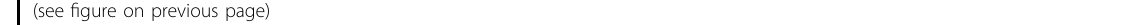
Fig. 5 Glutamine oncometabolites and energy production from glutamine. a Several mutations in enzymes in the glutaminolysis pathway are responsible for the production of oncometabolites. Mutation of IDH1 and IDH2 produces R-2-HG from α -KG, which, when accumulated, leads to the inhibition of dioxygenases, in turn leading to the activation of TET and JHDM enzymes inside the nucleus. Mutation of SDH arrests the TCA cycle, resulting in an increase in the succinate concentration. A high concentration of succinate has an effect similar to the oncometabolite effect of R-2-HG. Additionally, impaired function of FH prevents further metabolism of fumarate, leading to its accumulation. FH impairment inhibits the function of Keap1 and PHD, which stimulates the transcription of protooncogenes. Gln glutamine, Glu glutamate, α -KG α -ketoglutarate, IDH isocitrate dehydrogenase, 2OGDH 2-oxoglutarate dehydrogenase, SDH succinate dehydrogenase, FH fumarate hydratase, R-2-HG R-2-hydroxyglutarate, Keap1 Kelch-like ECH-associated protein 1, PHD prolyl hydroxylase, TETs ten-eleven translocation enzymes, JHDMs JmjC domain-containing histone demethylases, Me methylation. b . Glutamine anaplerosis is a key mitochondrial metabolic pathway for cancer cell growth and survival. In fl ux of glutamine-derived α -KG into the TCA cycle replenishes the intermediates and consequently generates NADH, FADH 2 , and GTP. The generated GTP can be readily converted to an equal amount of ATP. Additionally, glutamate and α -KG produced via glutaminolysis participate in the malate- aspartate shuttle, promoting the transport of NADH from the cytosol into mitochondria. Elevated mitochondrial NADH and FADH 2 levels collectively contribute to enhanced ATP production via OXPHOS through the ETC. Gln glutamine, Glu glutamate, Asp aspartate, α KG α -ketoglutarate, GOT1/2 glutamic-oxaloacetic transaminase 1/2, MDH1/2 malate dehydrogenase 1/2, OAA oxaloacetate, OGC 2-oxoglutarate carrier, AGC aspartate-glutamate carrier, ETC electron transport